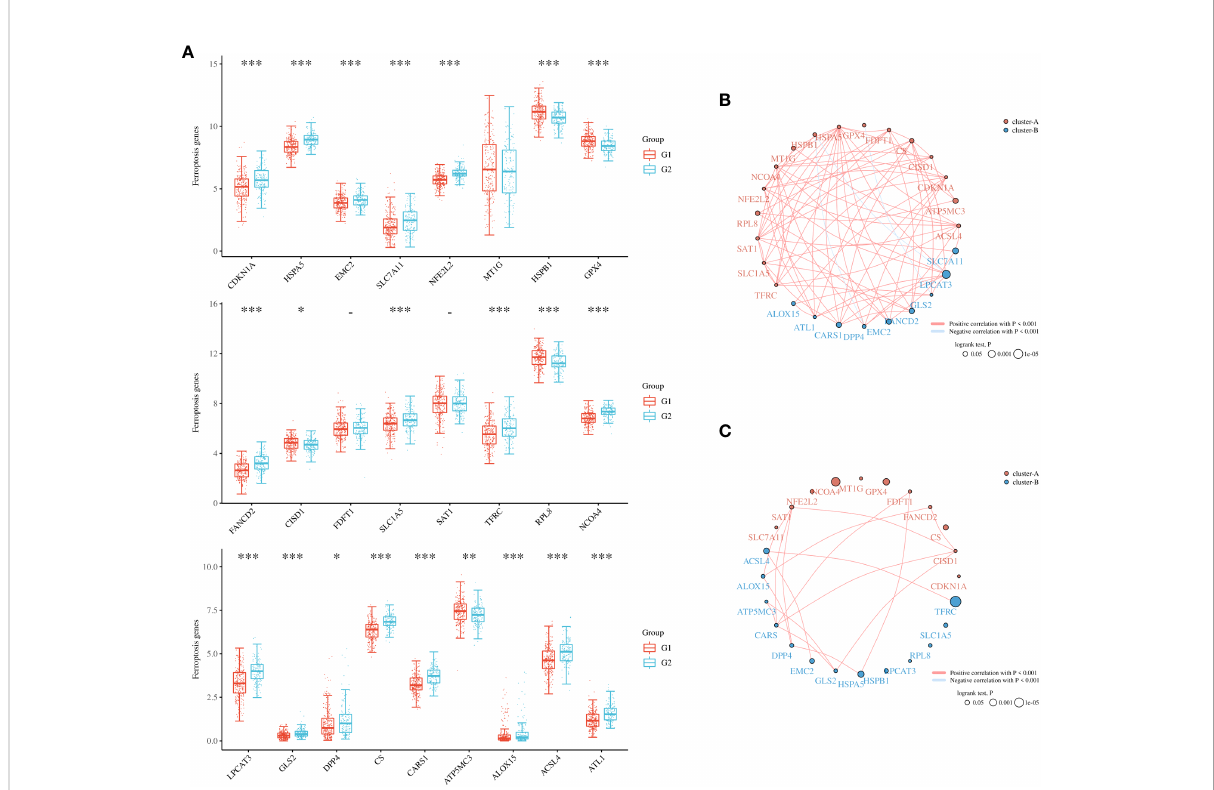
FIGURE 6 Ferroptosis levels in different subgroups of OSC. (A) Heatmap of ferroptosis-related genes in Cluster 1 and Cluster 2. (B) Network construction of ferroptosis-related genes in Cluster 1 samples. (C) Network construction of ferroptosis-related genes in Cluster 2 samples. (G1 is the group of the Cluster 1 for OC patients. G2 is the group of the Cluster 2 for OC patients.) *p < 0.05; **p < 0.01; ***p <